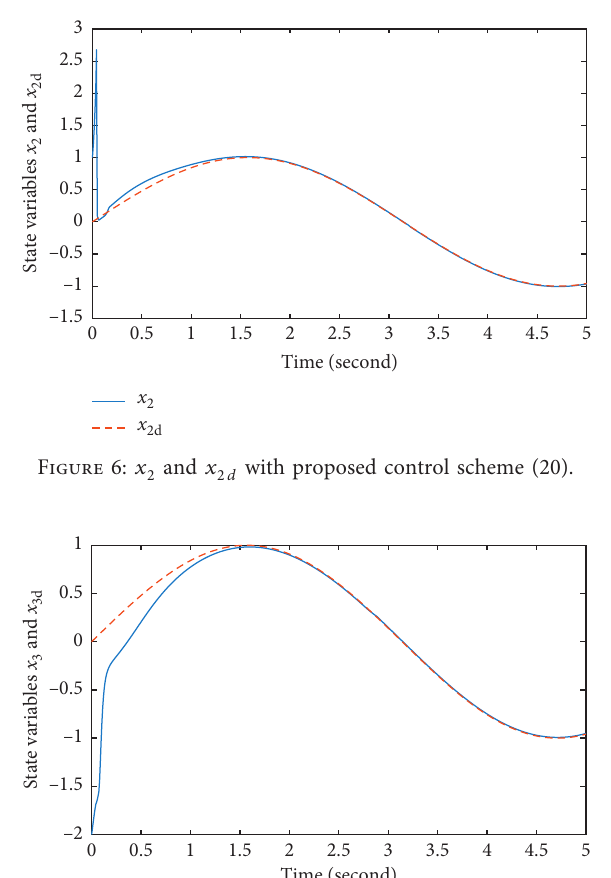
and x with proposed control scheme (20). 3 3 d